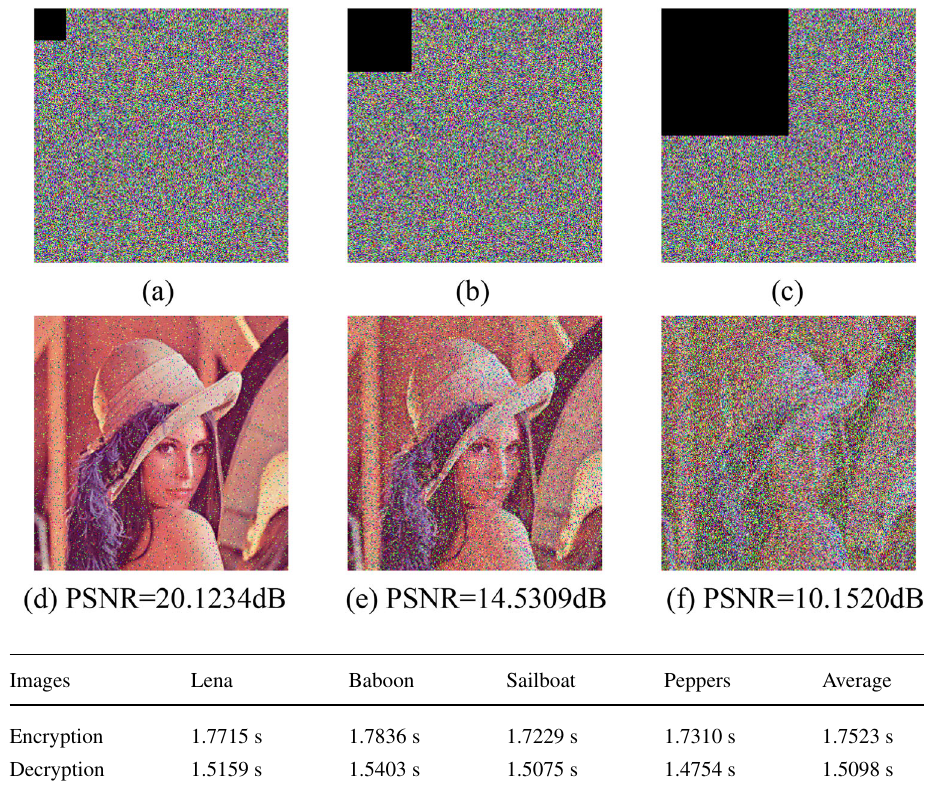
Fig. 13 The results of cropping attack